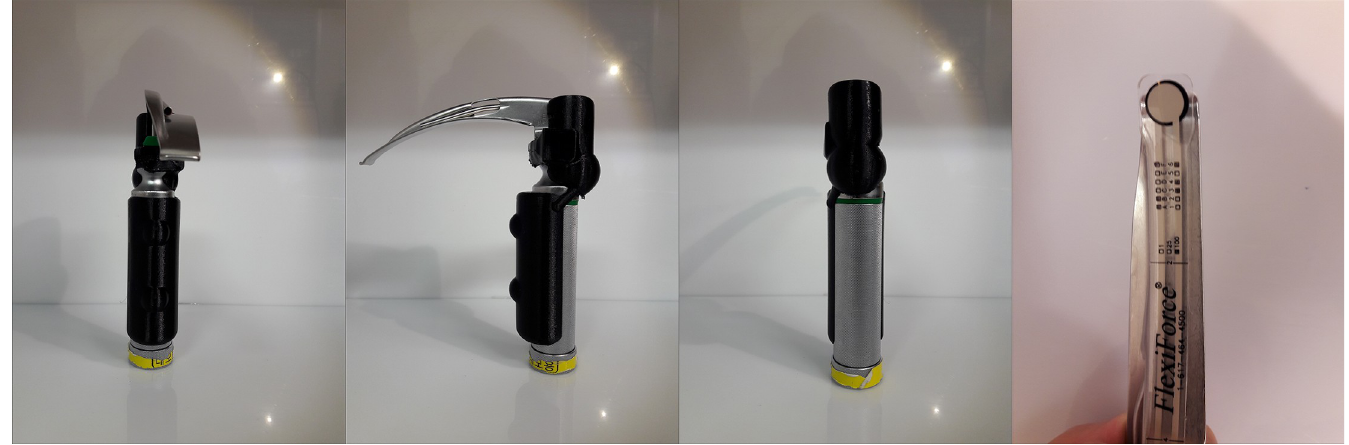
Fig 2. 3D-Printed ergonomic grip applied to the Macintosh